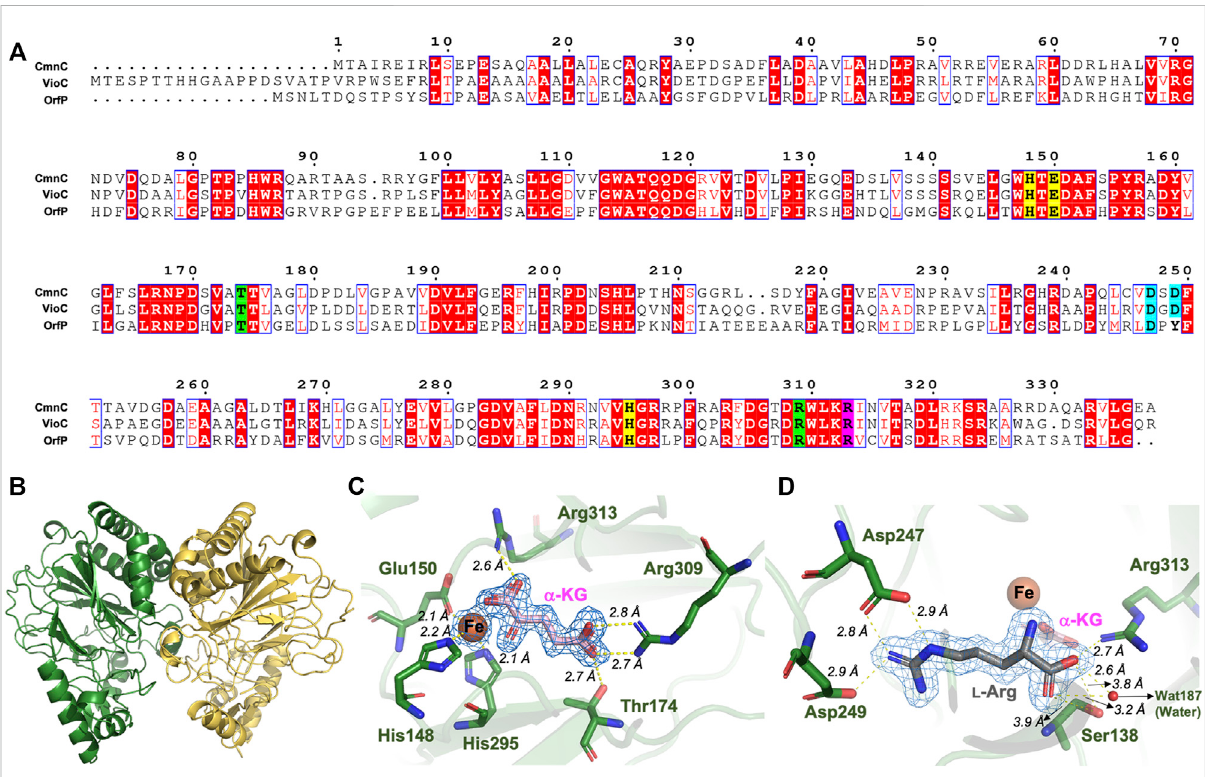
FIGURE 3 Sequence alignment and crystal structure of CmnC. (A) Sequence alignment of CmnC with VioC and OrfP. Aligned residues are colored on the basesofthelevelofconservation(redbackgroundshowsstrictidentity,redcharacterforsimilarity,andblueframeforsimilarityacrossgroup).The2- His-1-Glufacialtriadishighlightedinyellowbackground.Residuesinvolvedin α -KGand L -Argbindingarehighlightedingreenandcyanbackground, respectively. Residues involved in both α -KG and L -Arg binding are highlighted in purple background. The fi gure was generated by ESPript 3.0. (B) Overall structure of CmnC dimer. Two polypeptide chains are colored green and yellow, respectively. (C) Local view of the Fe and α -KG binding site. (D) Local view of the L -Arg binding site. The electrostatics and hydrogen bond interactions are depicted as yellow dotted lines. The composite (2 mF o – F c ) omit maps contoured at 1.0 σ in (C,D) are colored blue.